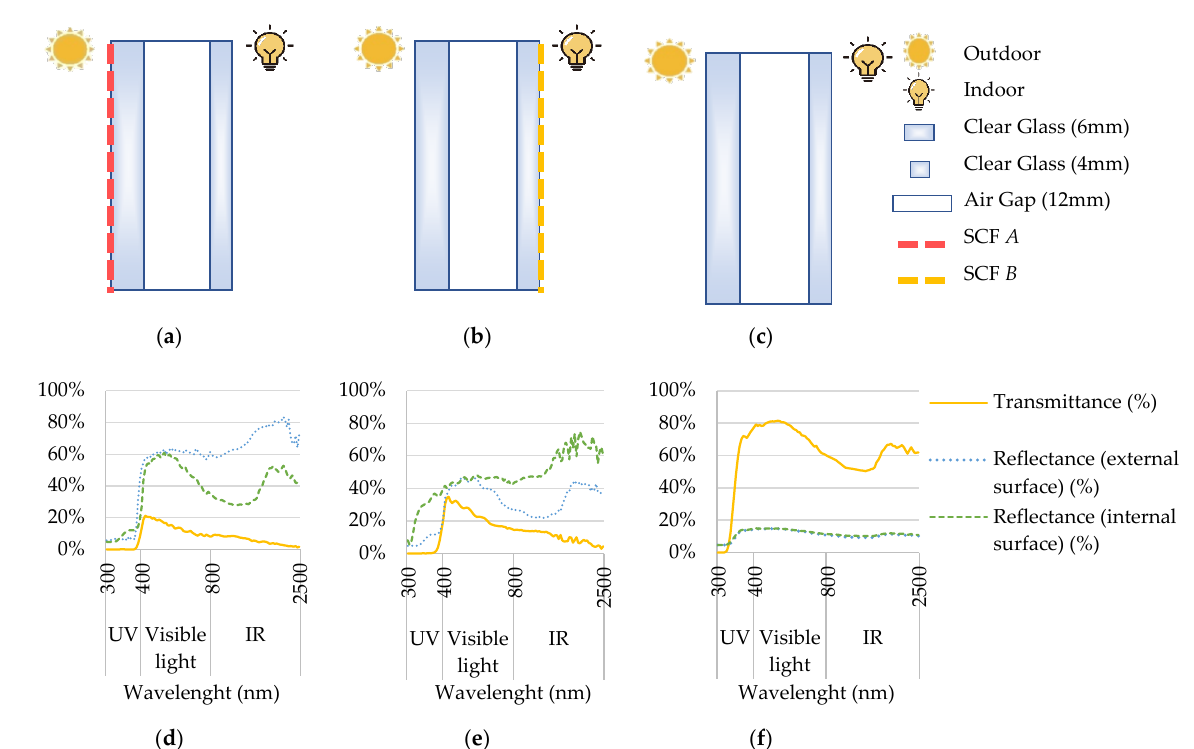
Figure 5. Glazing systems analyzed during the experimental campaign: ( a – c ) configuration of the glazing units with and without solar control films ( a : office I with SCF A; b : office II with SCF B; c : office III without SCF); ( d – f ) solar transmittance and reflectance (%) of the glazing systems computed using Optics software ( d : office I with SCF A; e : office II with SCF B; f : office III without SCF).